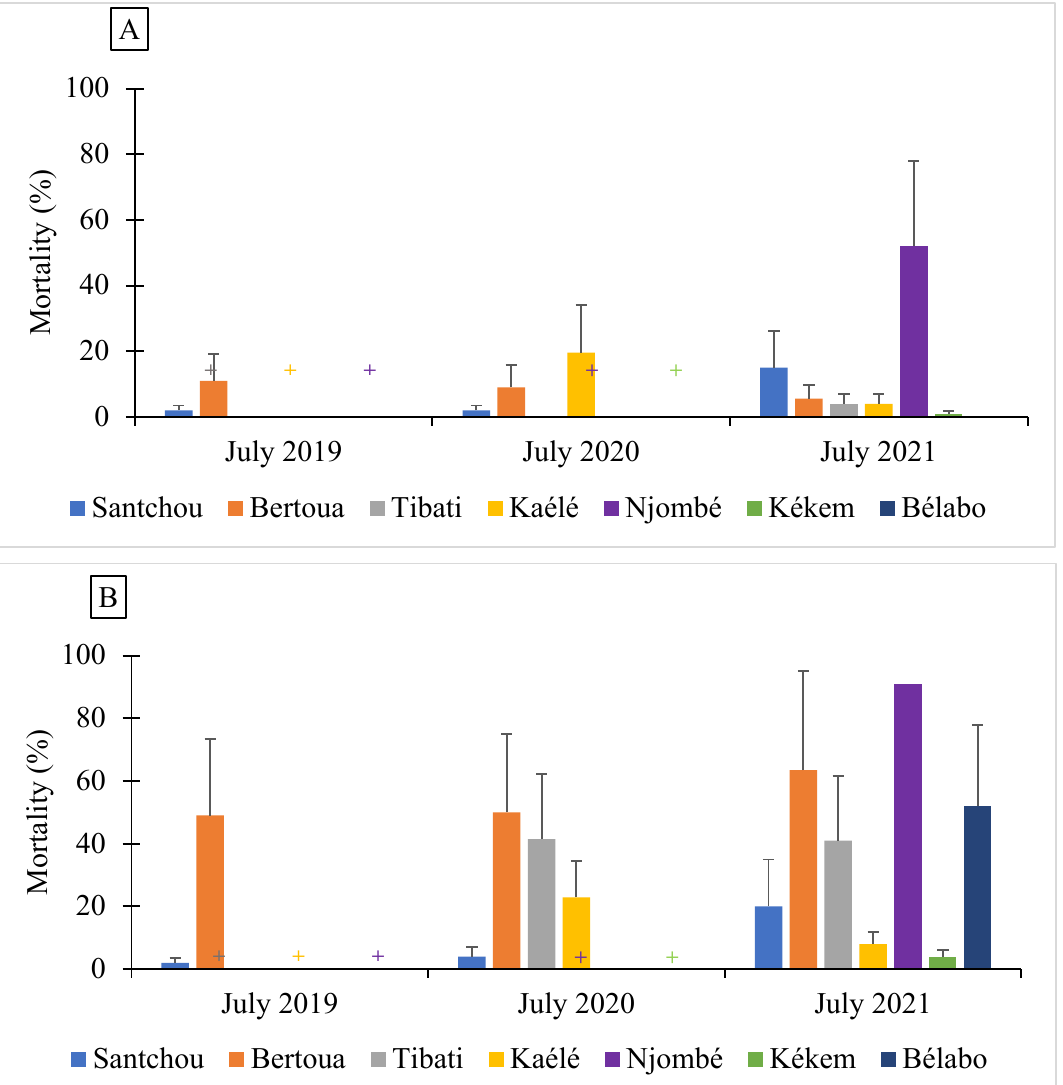
Figure 2. Susceptibility profile of Anopheles gambiae s.l. to permethrin 0.75% ( A ) and deltamethrin 0.05% ( B ) (+ no bioassay conducted in the site).